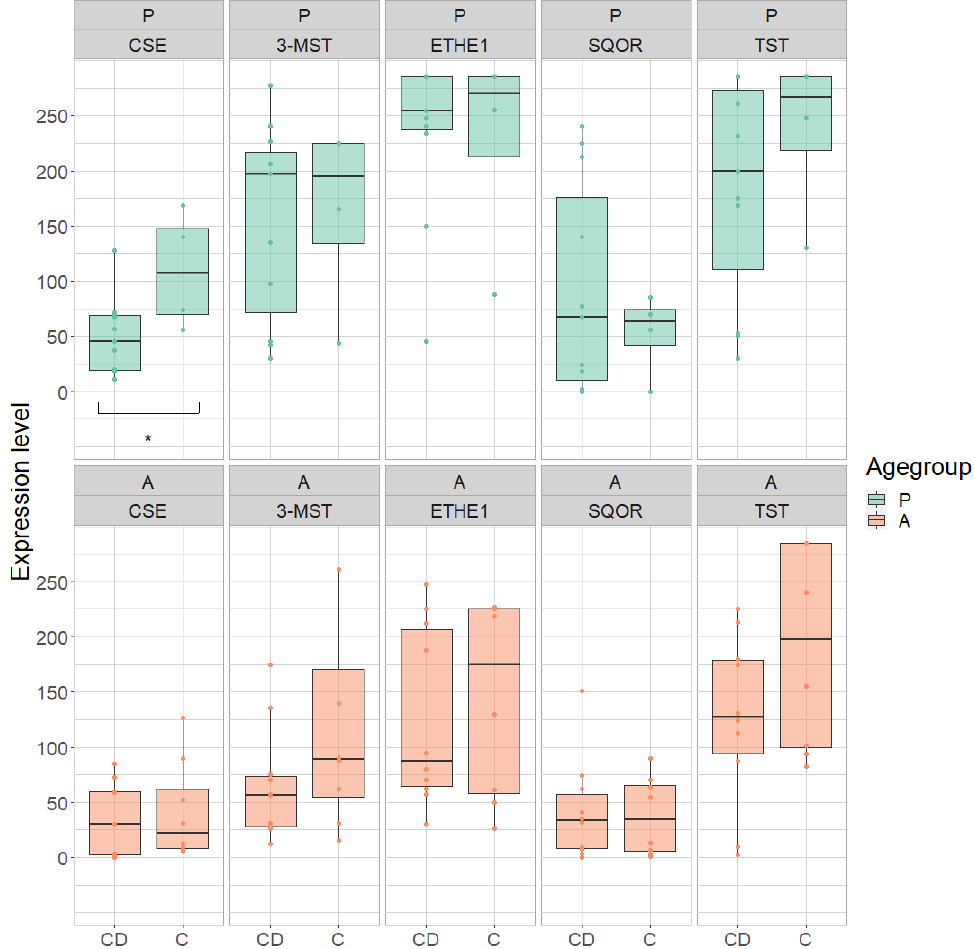
Figure 8. Expression of cystathionine- γ -lyase (CSE), 3-mercapto-sulfurtransferase (3-MST), ethylmalonic encephalopathy 1 protein (ETHE1), sulfide:quinone oxidoreductase (SQOR) and thiosulfate sulfurtransferase (TST) in pediatric (P) and adult (A) samples in the terminal ileum in Crohn’s disease (CD) compared to healthy controls (C). Range of expression levels from a minimum of 0 to a maximum of 300. * = p -value < 0.05.